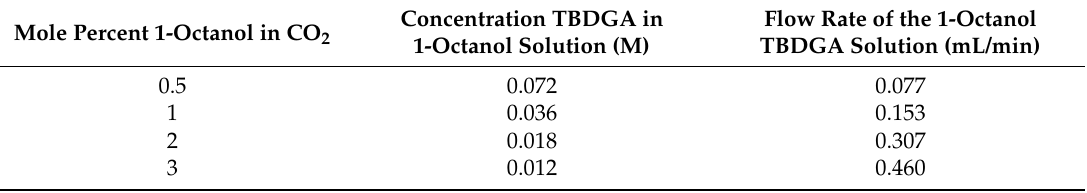
Table 1. Mole percent solution and flowrates for the varying mole percent 1